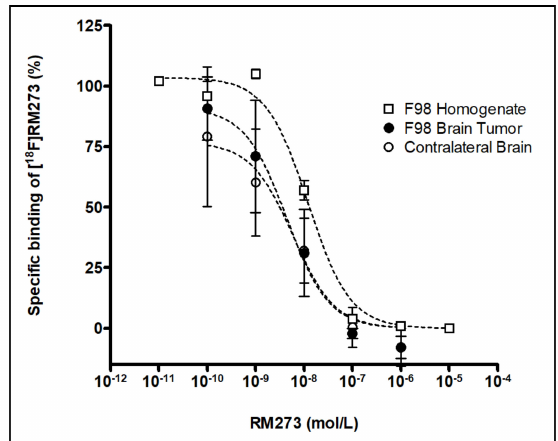
Figure 3. Determination of K D and B max values of [ 18 F] RM273 . Homologous competition studies were performed by incubation of [ 18 F] RM273 at 5–7 different molar activities either with membrane homogenates of F98 cells (open squares) or cryosections of rat brain ( n = 2) obtained about three weeks after stereotactic implantation of F98 cells (tumor region = filled circles; contralateral region = open cir- cles). Nonspecific binding was determined by addition of 1 µ M ISO-I. The K D values were calculated according to the modified Cheng–Prusoff transformation ( K D = K i = IC50—working concentration of the radioligand): K D F98 homogenate = 12 nM, K D F98 tumor = 4.82 nM, and K D contralateral brain = 2.93 nM. For the F98 cell homogenate, the maximum number of binding sites B max was calculated by division